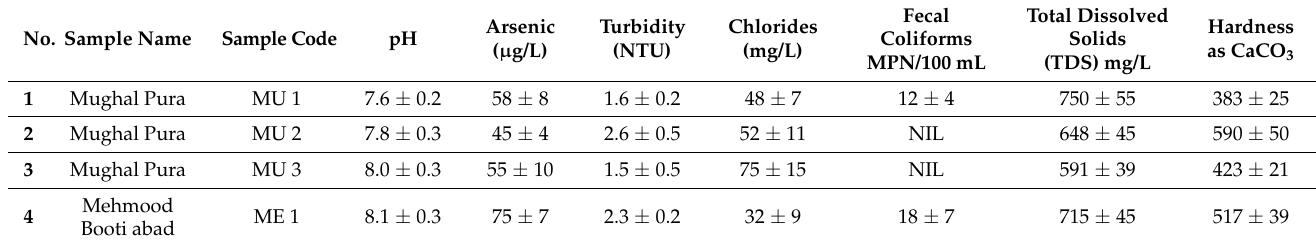
Table 3. Results of the characterization of nine (9) locations in